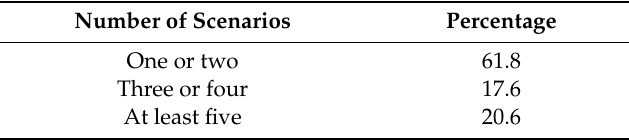
Table 7. Experimental simulation scene selections